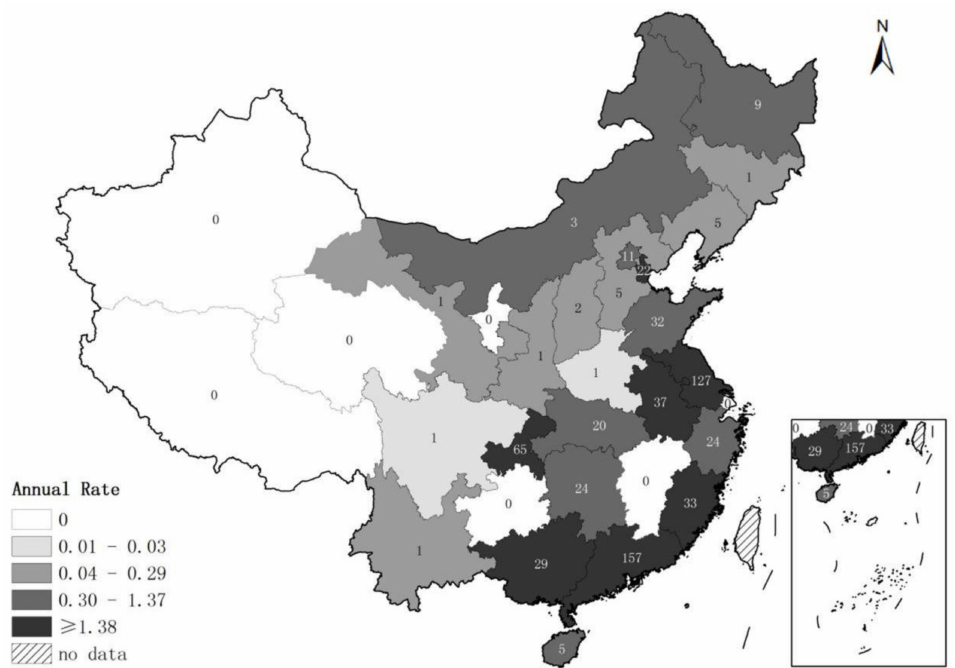
Figure 1. Annual rate of reported norovirus outbreaks per 10 million population by province in China, 2014–2017. The number given in each province indicates the total number of outbreaks over the 4-year study period; the shading denoted by the legend indicates the reporting rate by quartiles.